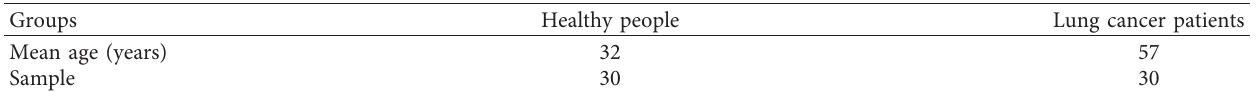
Figure 1: Scheme of the hairpin DNA-functionalized SERS platform for rapid detection of miR-196a expression in serum of lung cancer patients. Table 1: Demographics of volunteers.